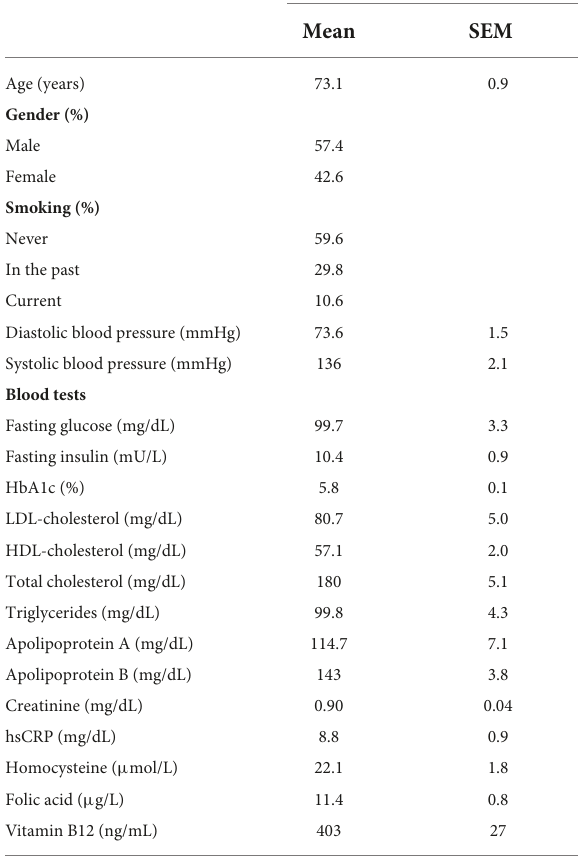
TABLE 4 Baseline demographic, clinical and biochemical characteristics of the MCI patients.